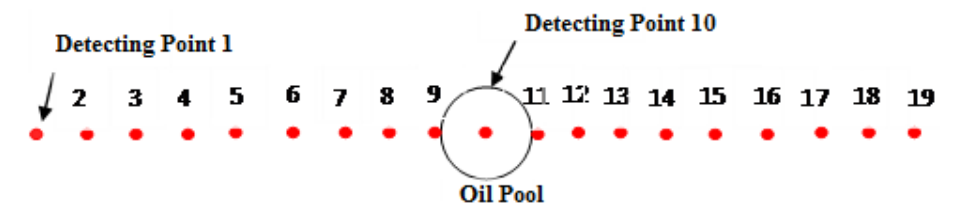
Figure 12. Top view of detecting points.